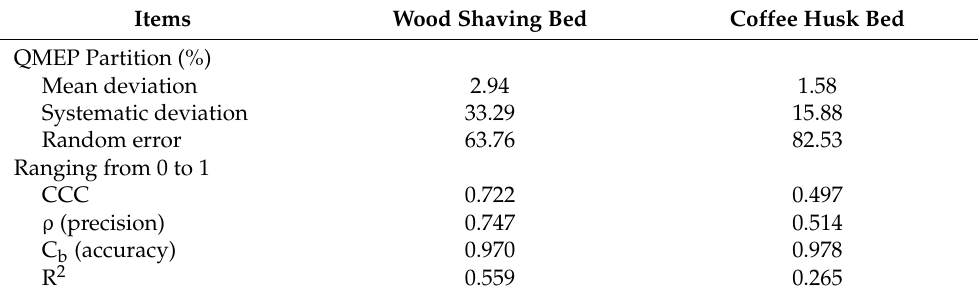
Table 6. Measurements of adequacy of models for the prediction of ammonia emissions in wood shavings bed and coffee husks bed, estimated by cross-validation technique.